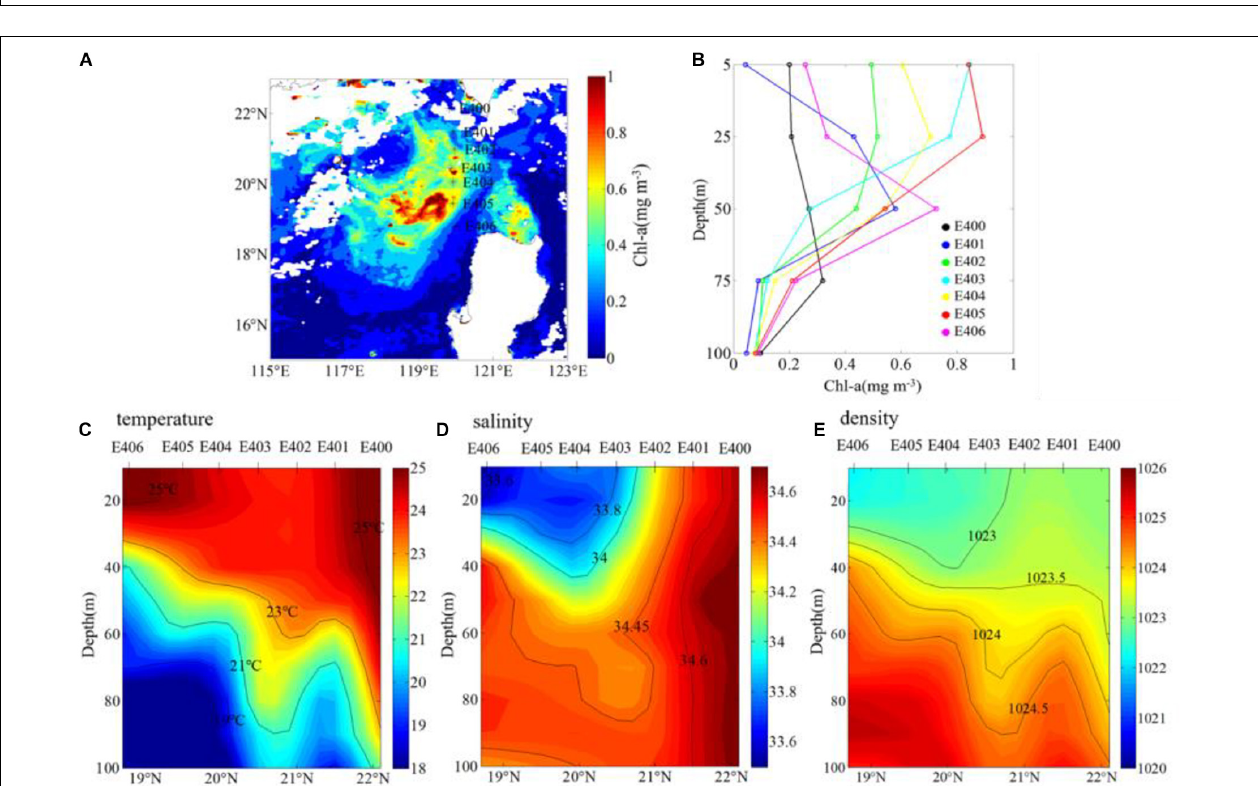
FIGURE 8 | In situ observations during 27–30 January 2010: (A) the location of Stations E400–E406, the background shading denotes surface mean Chl- a during 27–30 January 2010 which obtained from GlobColour (daily data) (B) vertical profiles of Chl- a (mg m − 3 ). Cross-section diagram of (C) temperature ( ◦ C), (D) salinity (psu), and (E) density (kg m − 3 ) along the E transect.